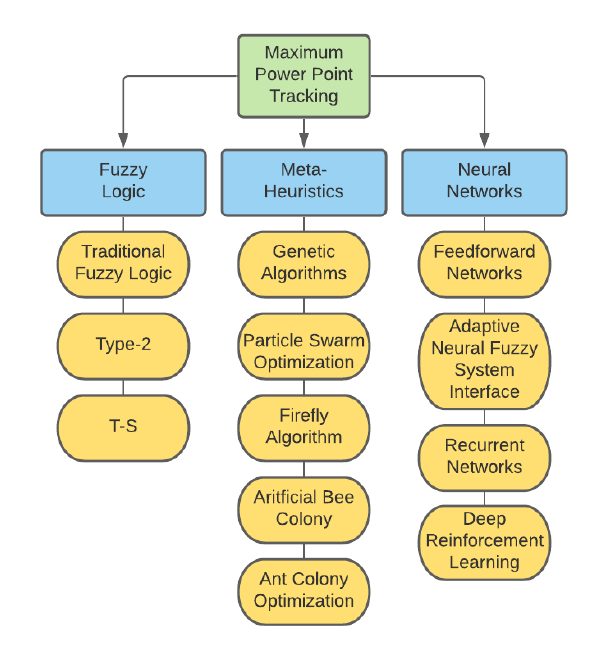
Figure 4. Taxonomy of most used IA method for